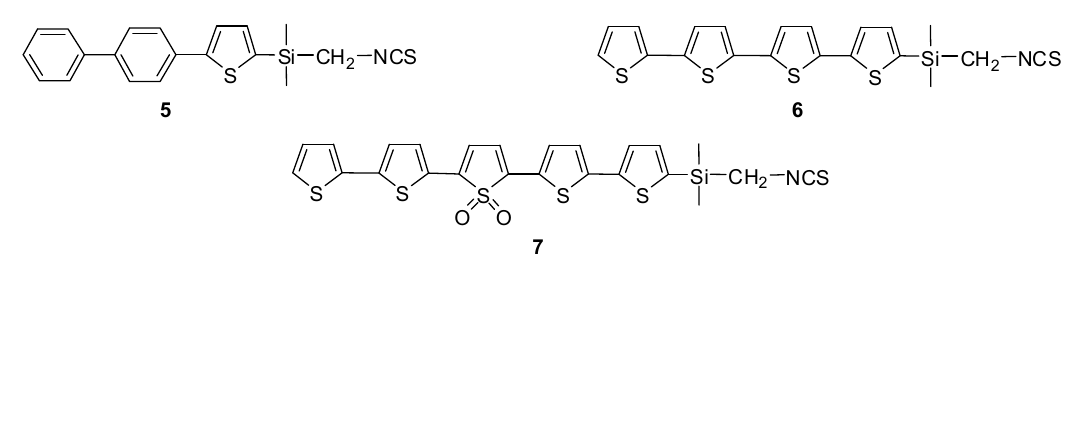
Figure 8. Structure of isothiocyanates 5 – 7 and their UV absorbance (top) and fluorescence emission (bottom)